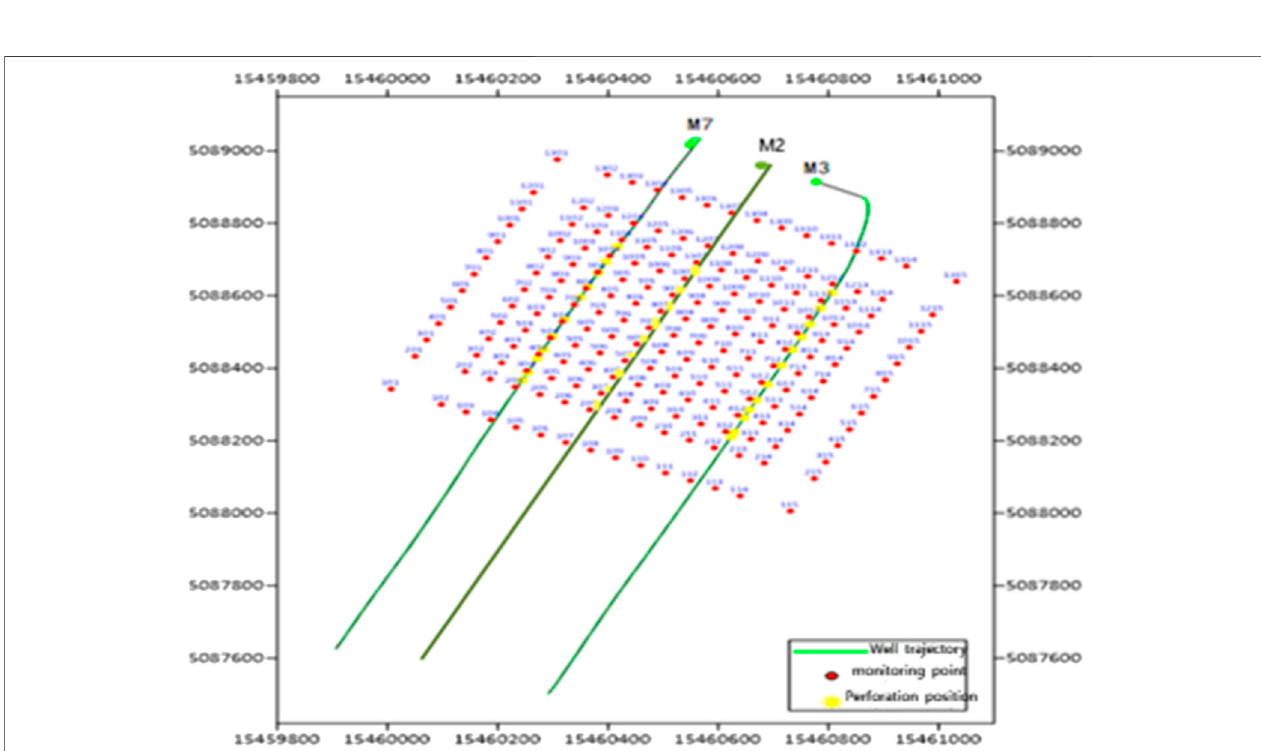
FIGURE 8 | Deployment of measuring